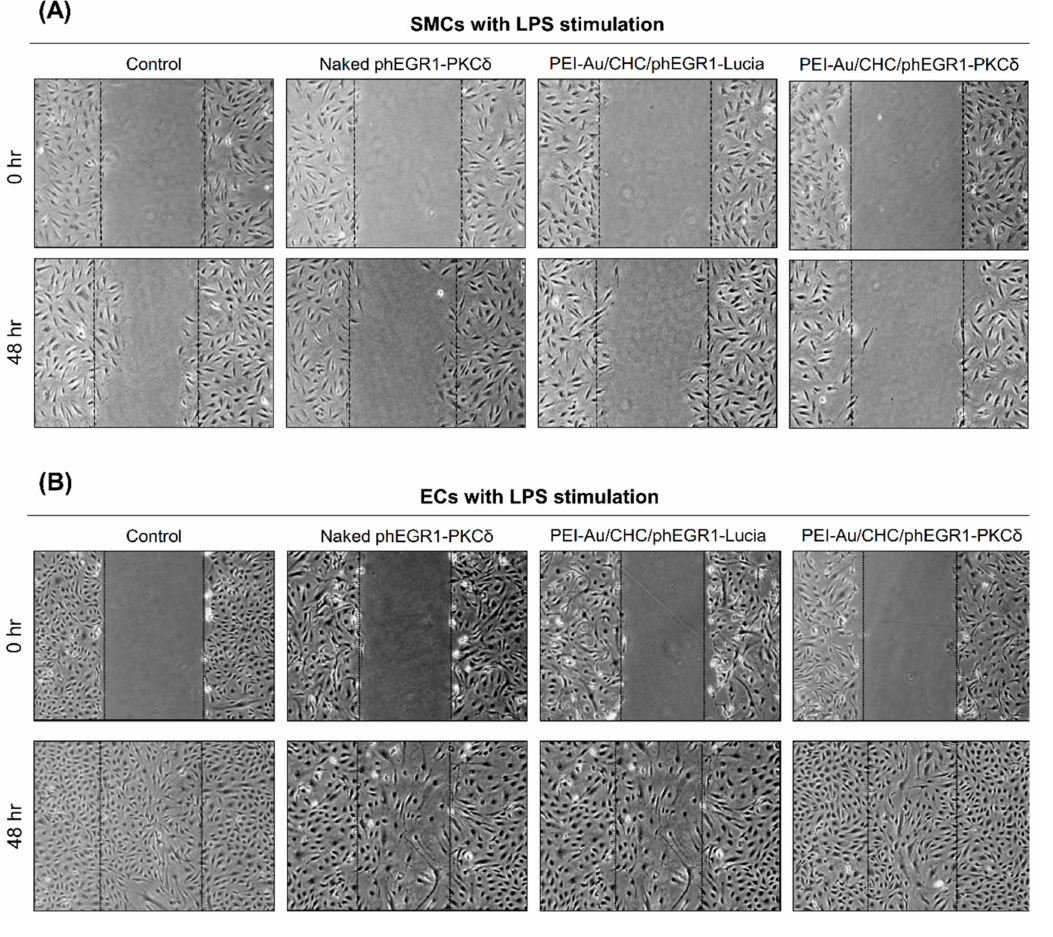
Figure 8. Cell migration assay performed on the serum-starved ( A ) SMCs and ( B ) ECs transfected with naked phEGR1-PKC δ , the PEI-Au / CHC / phEGR1-Lucia complex, and the PEI-Au / CHC / phEGR1-PKC δ complex under the conditions with LPS stimulation. Cell migration was measured after 48